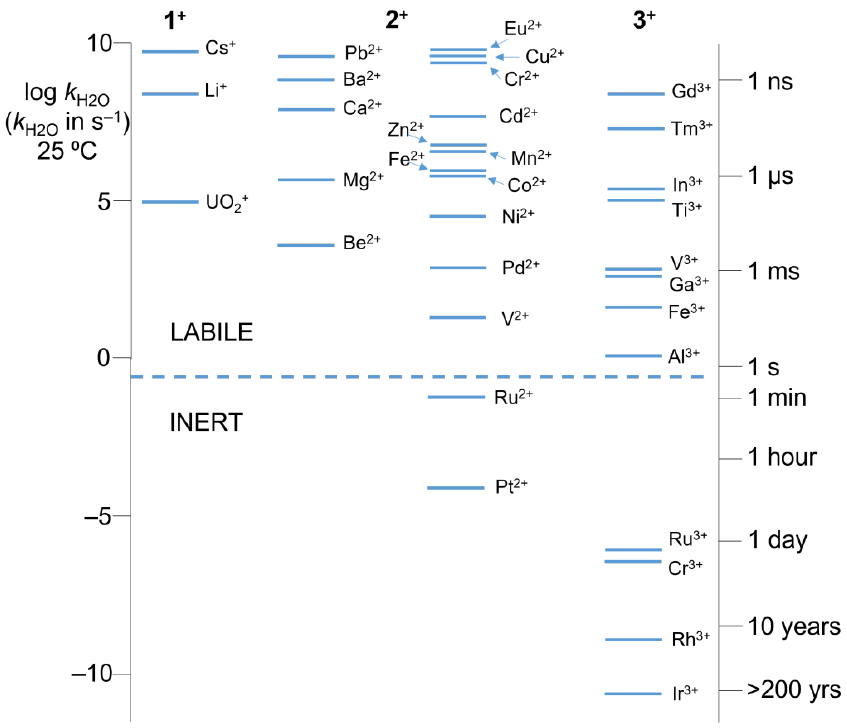
Figure 4. Water exchange rate constants (log k H2O , s −1 ) and mean lifetime (τ H2O , s) for primary shell water molecules on aqua metal ions at 25 °C. The dotted line represents Taube’s inert/labile boundary [70]. Reproduced with permission from Ref. [71]. Copyright 2005 from American Chemical Society.